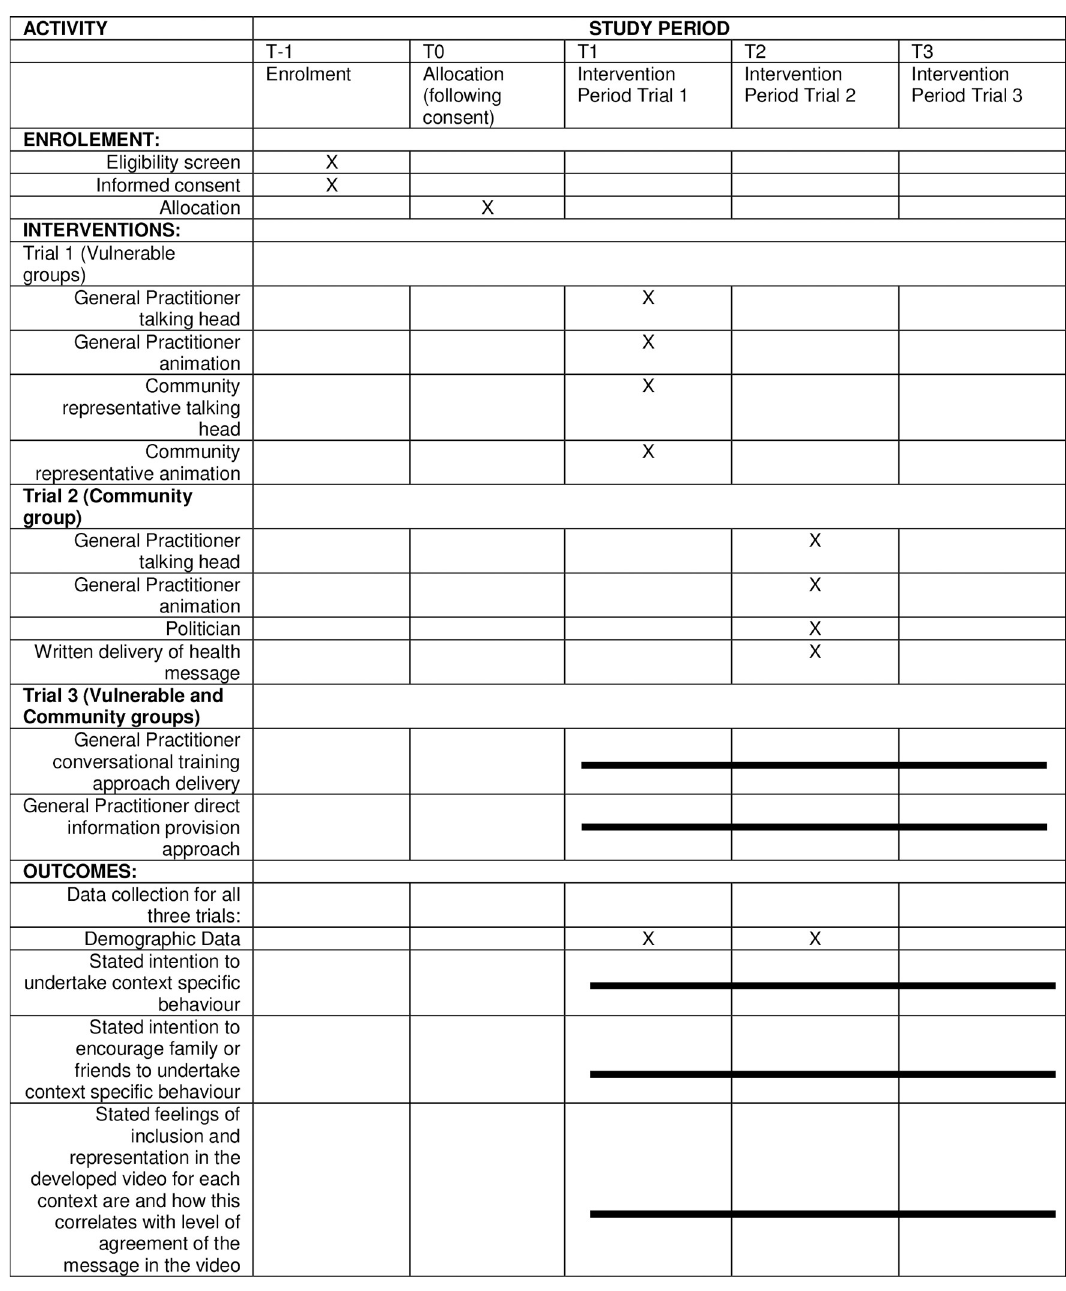
Fig 1. SPIRIT flow diagram: Schedule of enrolment, interventions, and assessment